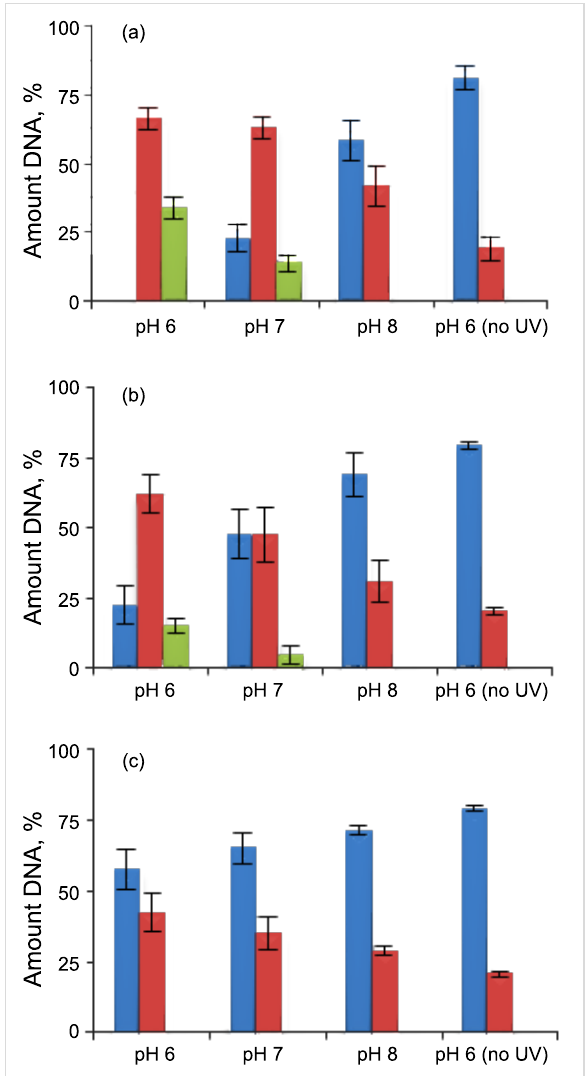
Figure 7: Quantified DNA cleavage data for 1 (a), 6 (b) and 7 (c). Blue: Form I (supercoiled) DNA; red: Form II (relaxed) DNA; green: Form III (linear) DNA. Reported values represent the average of four experi- ments.